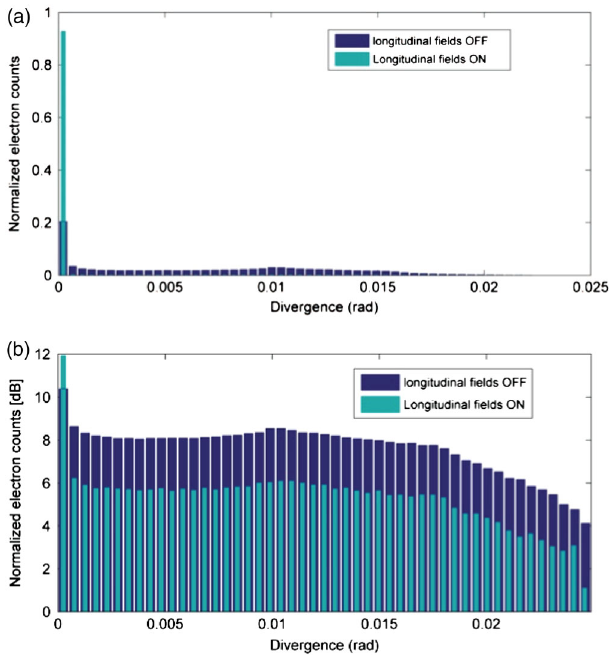
FIG. 3. Influence of longitudinal fields at focus. Simulated azimuthal distribution (divergence) of electrons above 40 keV kinetic energy and within 25 mrad with and without the presence of longitudinal components of the driving laser field in linear (a) and logarithmic scale